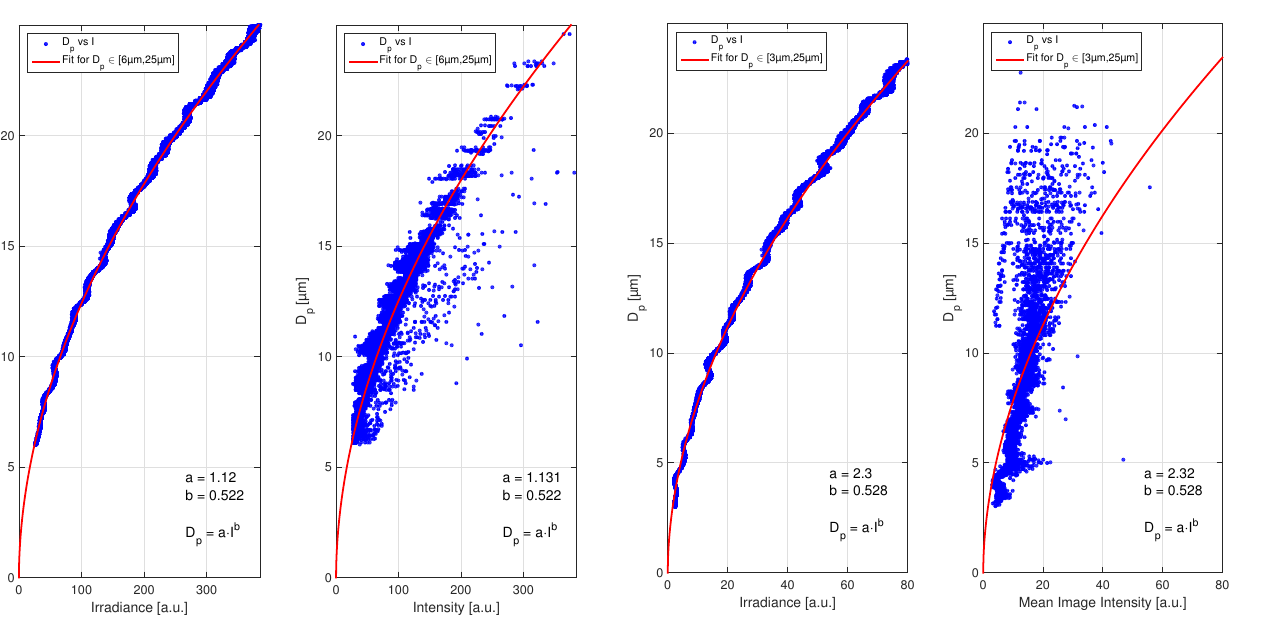
Figure 5. Size calibration of the PPD-2K trigger detector. Left panel: scattered irradiances in 7.4 to 25.6 ◦ forward direction calcu- lated by Lorenz–Mie theory for water droplets. Right panel: analy- sis result obtained from the measurement of a dense droplet cloud during RICE 01 at the AIDA chamber. The spread of the data points is mainly due to electronic noise.